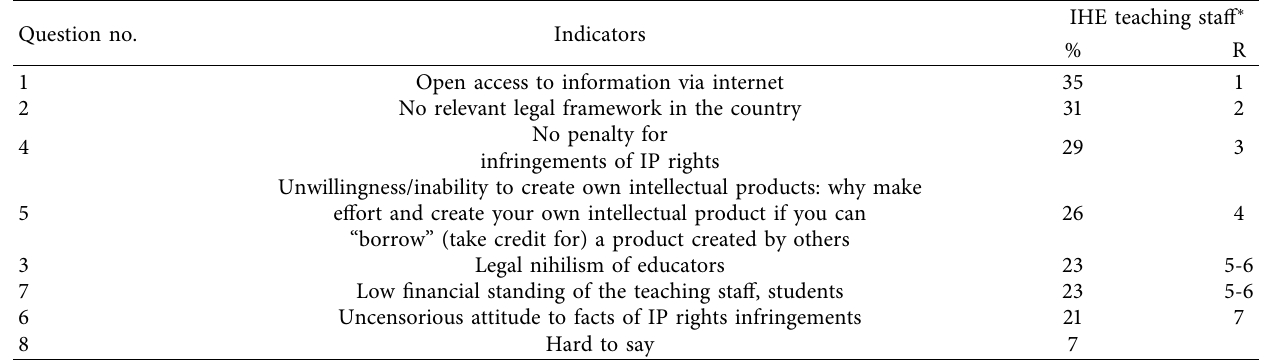
Table 5: Reasons behind IPR infringements.